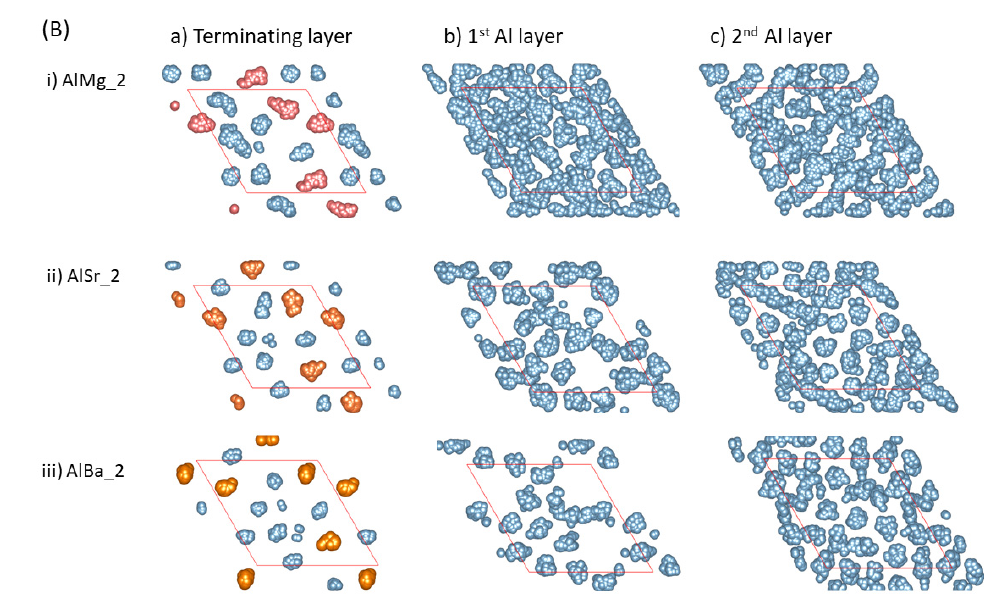
Figure 3. The summed atomic con fi gurations of the terminating Al/AE layer ( a ), the fi rst Al layer ( b ) and the second Al layer ( c ) of the S1 (( A ), top) and S2 (bo tt om, ( B )) interfaces of L-Al/L-Al/ γ -Al 2 O 3 systems over 3 ps. The silvery spheres represent Al, the dark brown spheres represent O, and the gold spheres represent the AE atoms.